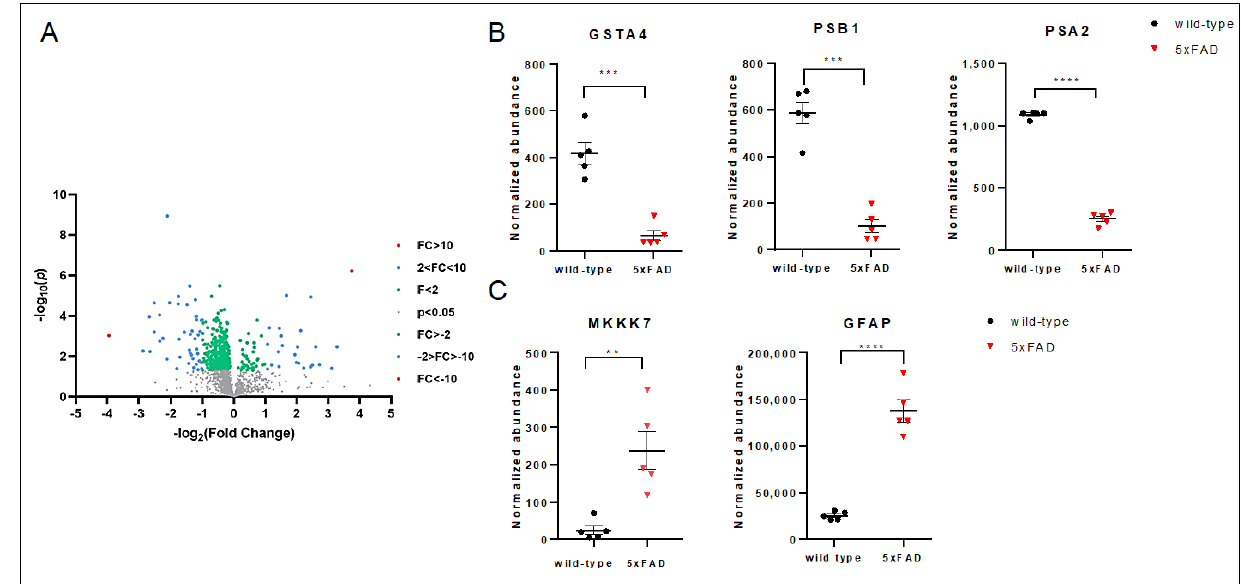
Figure 5. Mass spectrometry analysis of cortex lysates of 5xFAD and wt mice at 10 months of age. ( A ) Volcano plot illustrates significantly differentially abundant proteins. The − log10 (Benjamini– Hochberg corrected p value) is plotted against the log2 (fold change: 5xFAD/wt). p = 0.05 is the significance threshold (prior to logarithmic transformation). ( B ) Significant decrease was observed in GSTA4, PSB1, PSA2 proteins in tg vs. control mice. ( C ) A significant increase in